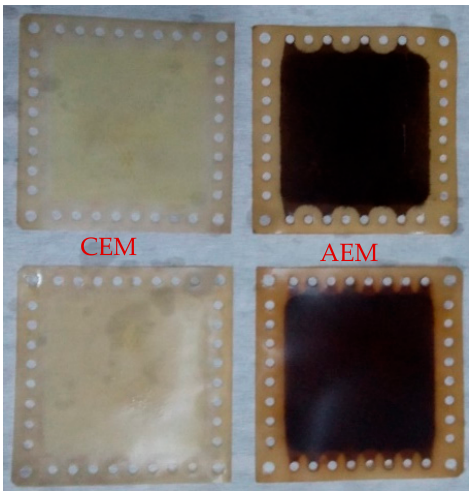
Figure 8. Ion exchange membranes after the BPMED process.